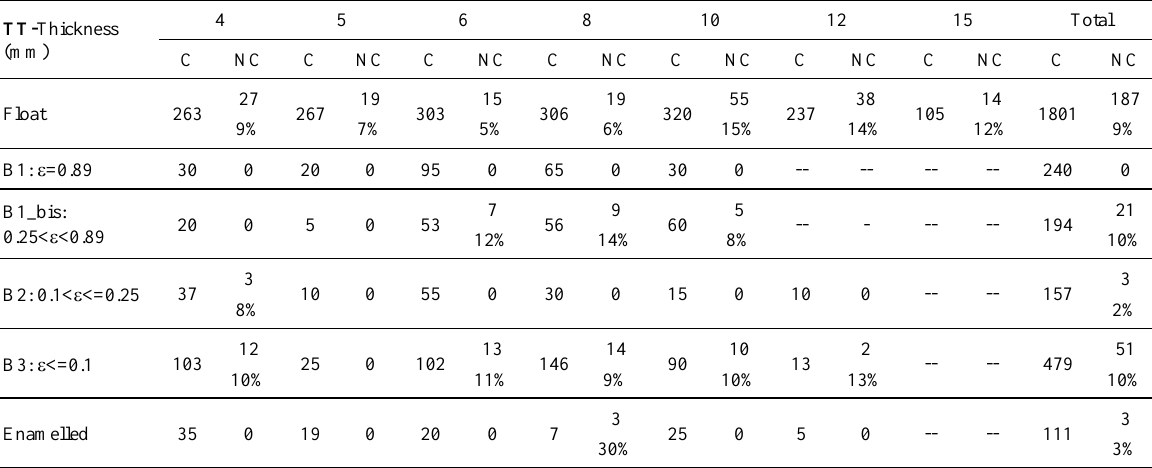
Table 3a: Number of TT tested for FR